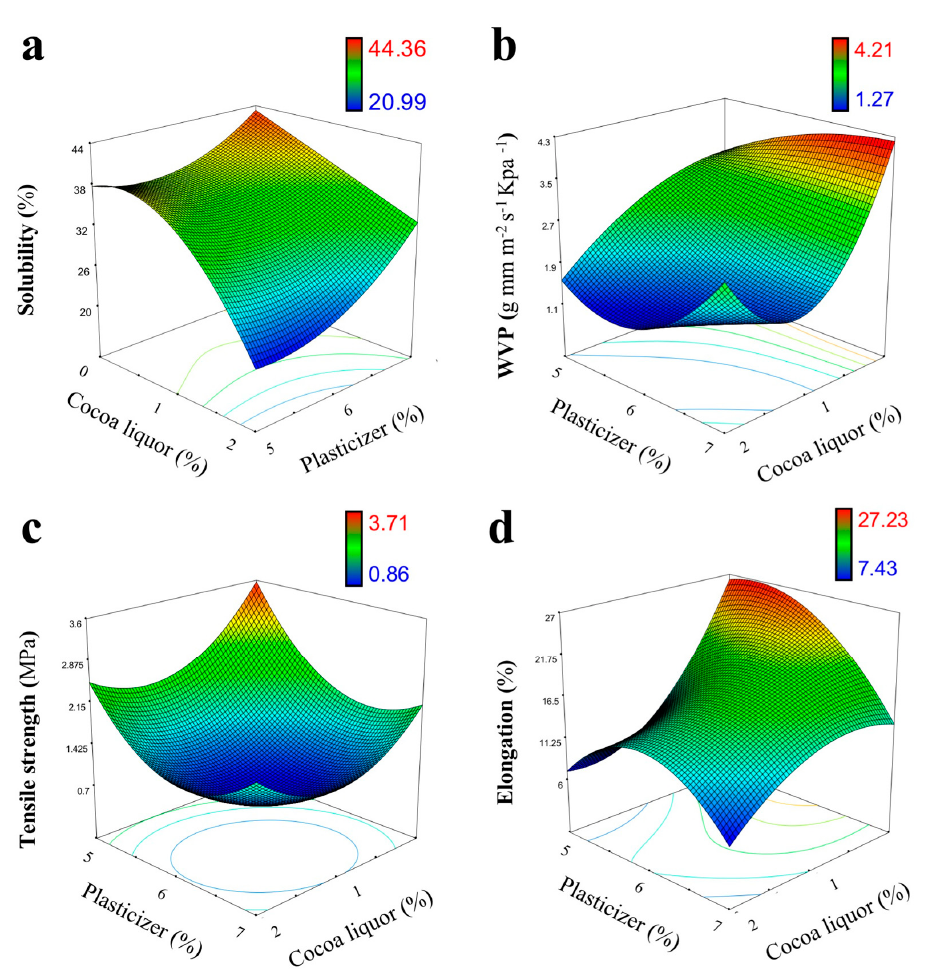
Figure 2. Three-dimensional response surface plot for the interactive effect of independent variables (cocoa liquor concentration and plasticizer concentration) on: ( a ) solubility; ( b ) water vapor permeability; ( c ) tensile strength; and ( d ) elongation at break of the whey protein-based films with 8% protein content.